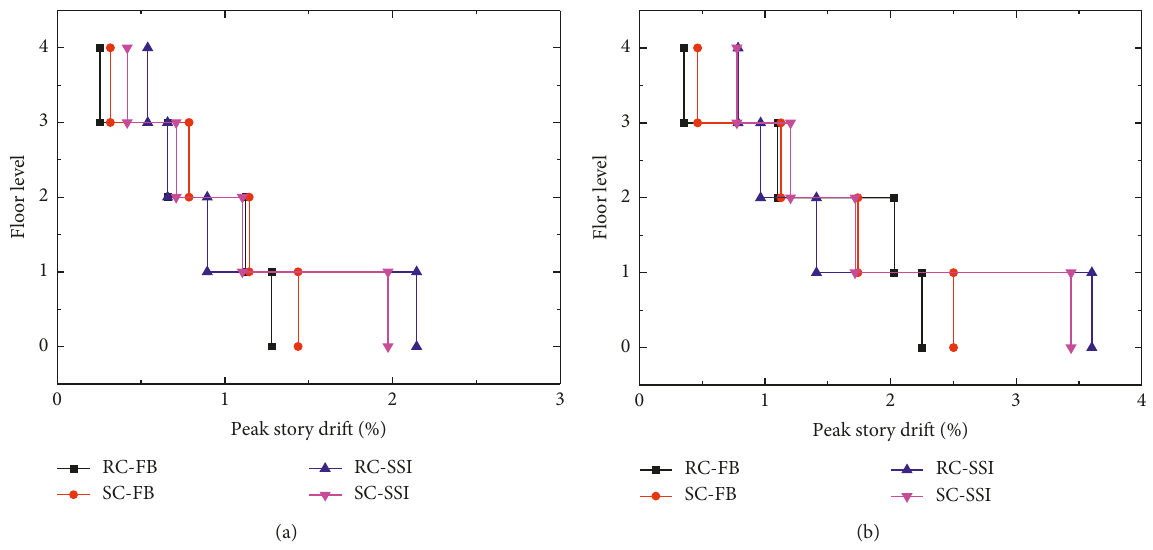
Figure 8: Peak story drift ratios of the RC and SC frames. (a) DBE. (b) MCE.